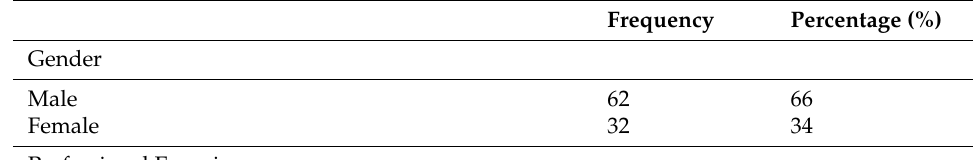
Table A1. Demographics of